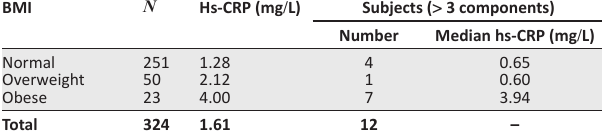
TABLE 2: Metabolic syndrome, body mass index (BMI) and high-sensitivity C-reactive protein (hs-CRP) levels amongst the study participants ( N = 324).